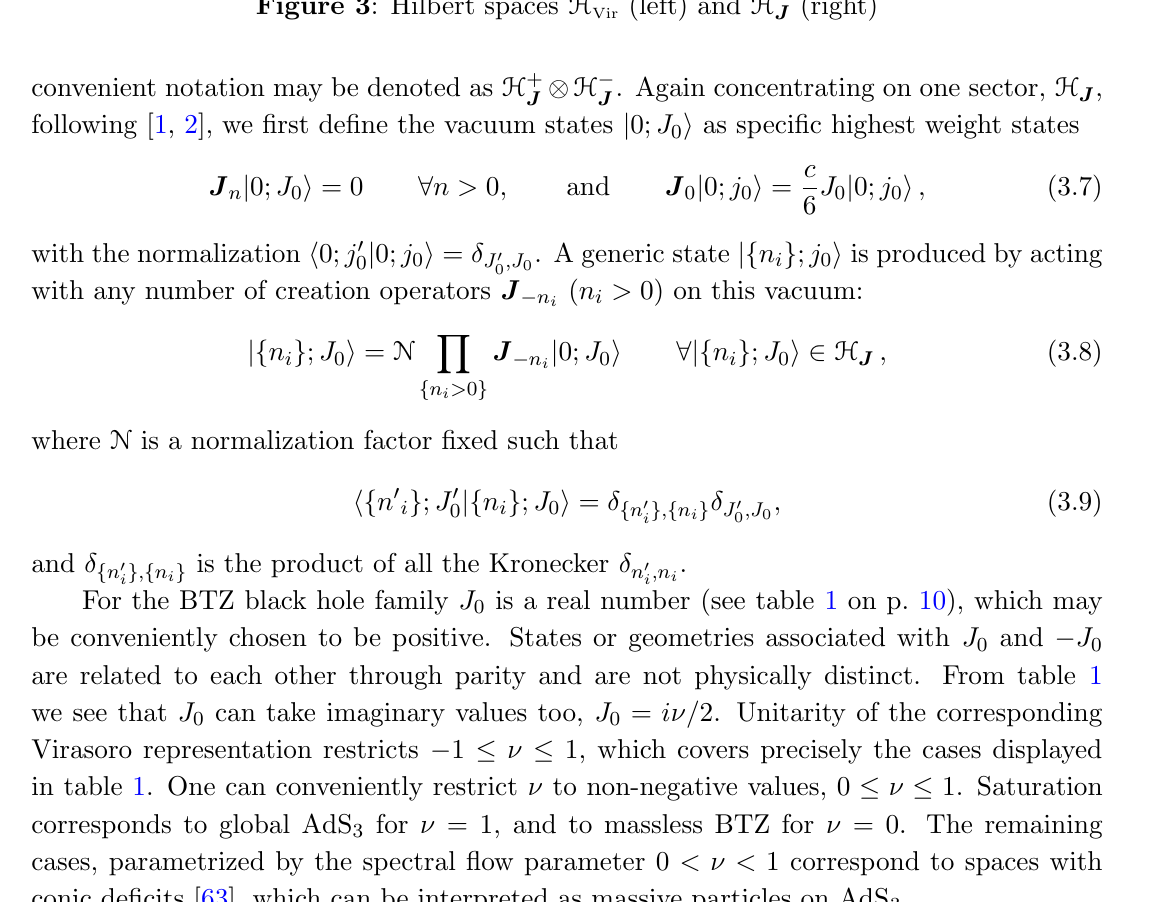
Figure 3 : Hilbert spaces H